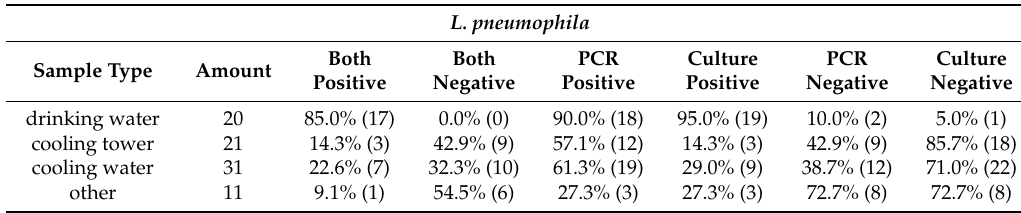
Table 2. Detection of L. pneumophila via culture and qPCR ( mip